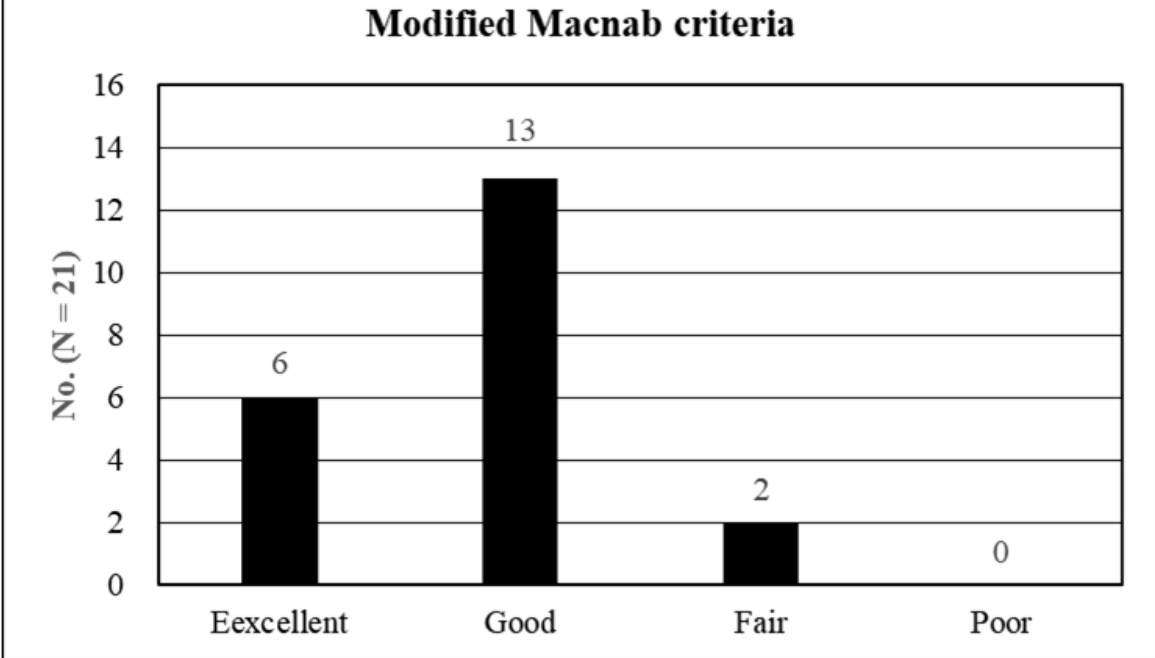
Figure 6. The global results based on the modified Macnab criteria were as follows: excellent in six patients (28.6%), good in 13 (61.9%), and fair in two (9.5%). Therefore, all patients showed clinical improvements, and the successful (excellent/good) rate was 90.5%.